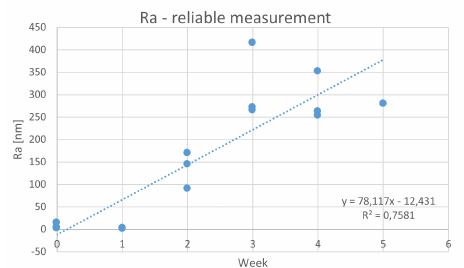
Figure 5. Relation between area roughness and du- ration of accelerated weathering of